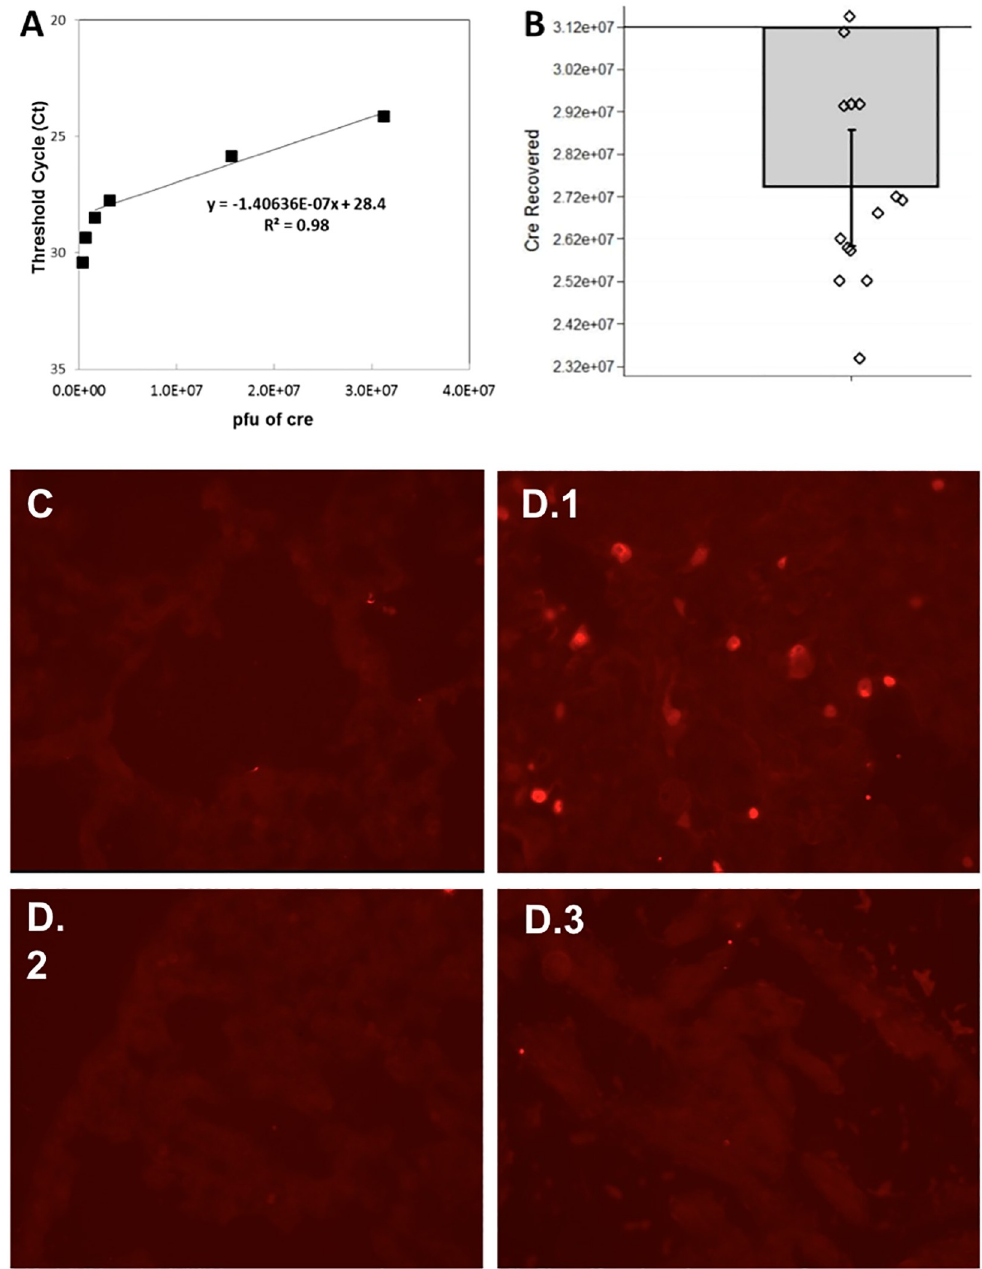
Fig 1. Validating intrathoracic injection technique. (A) A standard calibration curve was made using known quantities of Ad5CMVCre to then quantify unknown samples of Ad5CMVCre. Six different known concentrations of Ad5CMVCre were spiked into lung tissue to make the standard calibration curve: 3.12x10 5 , 6.24x10 5 , 1.56x10 6 , 3.12x10 6 , 1.56x10 7 , and 3.12x10 7 pfu. (B) Amount of Ad5CMVCre (in pfu) measured in 14 mice that had their left lung injected with 3.12x10 7 pfu Ad5CMVCre virus. Measurements were made using the TaqMan real-time PCR assay. The bar plot shows the mean with standard error and overlaying dot plot shows measurements of individual animals (n = 14). pfu = plaque- forming unit, a standard measure of the number of particles capable of forming plaques per unit volume. (C-D) To characterize Ad5CMVCre activity in the left lung of Kras G12D+/- ; p53 fl/fl ; myristolated-p110 α fl/fl -ROSA-gfp mice, gfp immunohistochemistry was used to detect Cre-recombination effect within the left lung, 4 days after Ad5CMVCre injection. (C) A representative micrograph of no gfp/Cre-recombination in the left lung of a mouse that had no Ad5CMVCre virus injected serves as a negative control. ( D.1 ) A representative micrograph of activation of gfp/Cre- recombination in the left lung of a mouse that underwent Ad5CMVCre virus injection. To validate that the virus did not enter the bloodstream to turn on other primary cancers, ( D.2 ) is representative of no gfp/Cre-recombination activation in the right lung and ( D.3 ) is representative of no gfp/Cre-recombination activation in the heart.